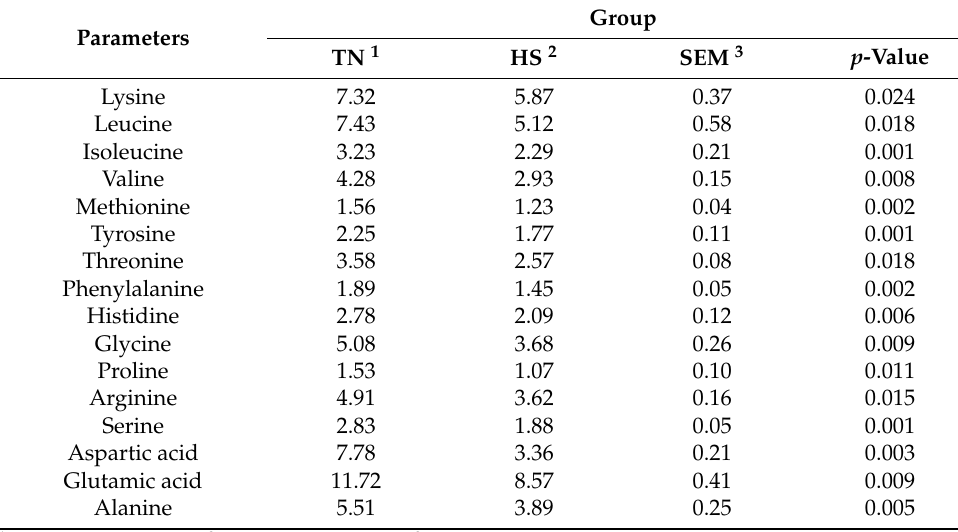
Table 5. Effect of chronic heat stress on amino acid profile (g/100 g) of thigh muscles in broiler